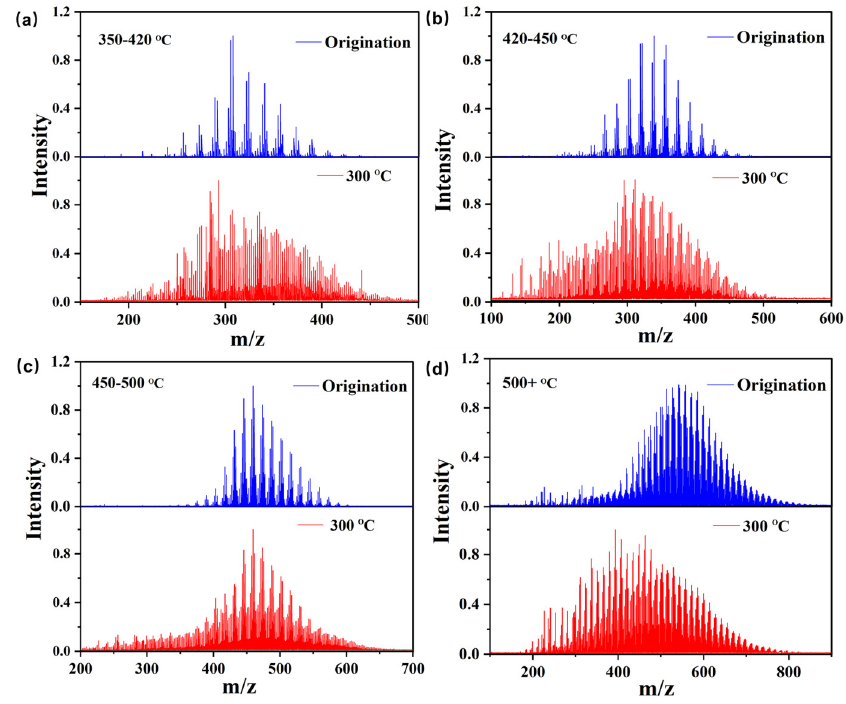
Figure 4. High-resolution spectra of pseudo-components in the range of 25–300 °C: ( a ) 350–420 °C; ( b ) 420–450 °C; ( c ) 450–500 °C; ( d ) 500+ °C.